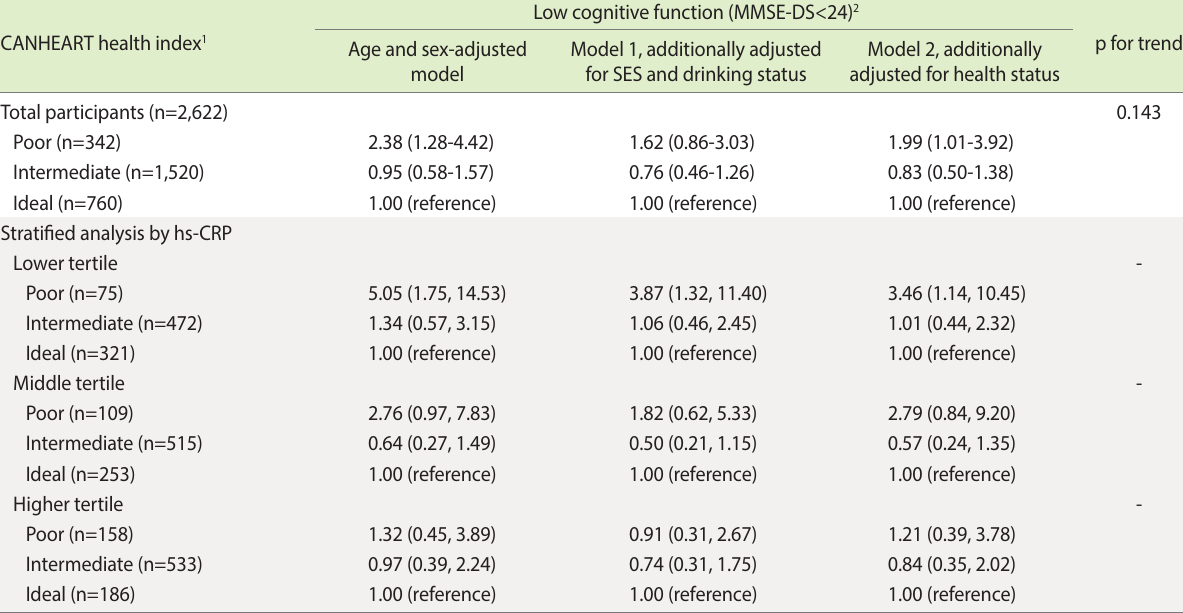
Table 2. Associations between the CANHEART health index and cognitive function by hs-CRP tertiles CANHEART health index